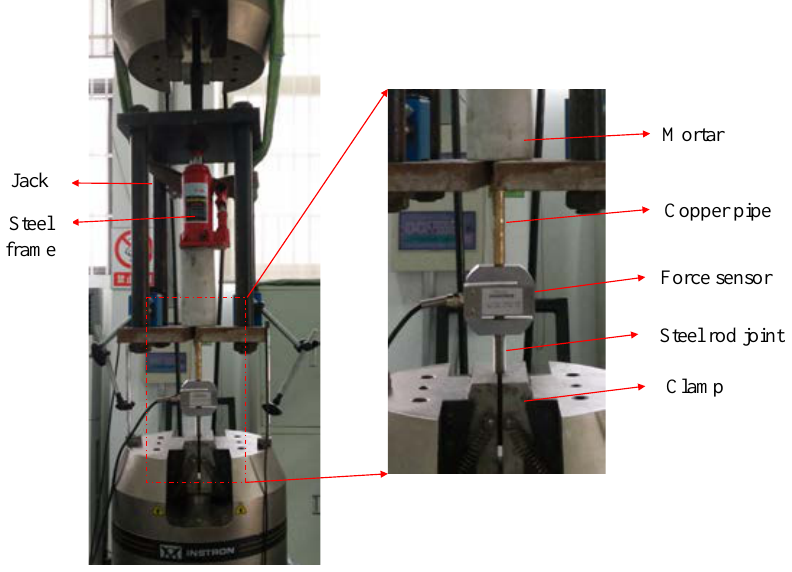
Figure 2. The device for single fibre pullout tests.